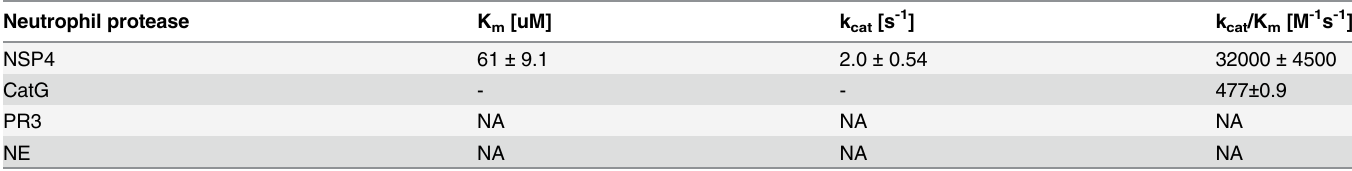
Table 2. Kinetic parameters/constants for the hydrolysis of Ac-hCha-Phe(guan)-Oic-Arg-ACC substrate by neutrophil serine proteases to three significant digits. Neutrophil protease